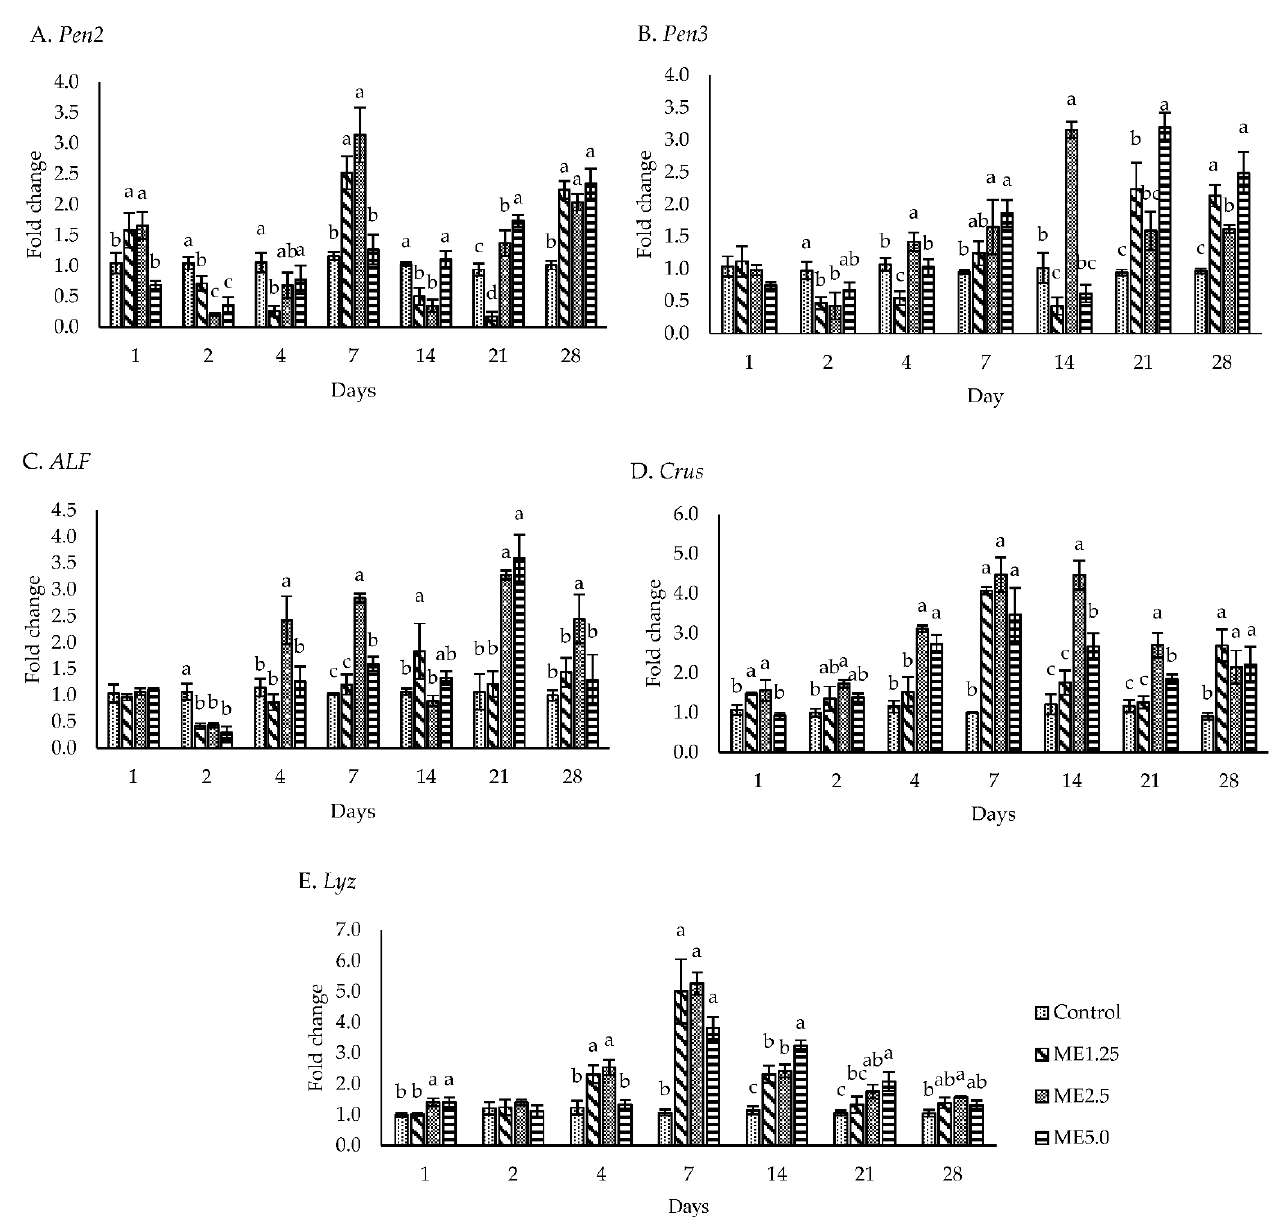
Figure 4. Antimicrobial peptides. The effect of different concentrations of moringa extract in diet (control, ME1.25, ME2.5, and ME5.0) on the expression of Pen2, Pen3 , ALF , Crus , and Lyz in the hemocytes of whiteleg shrimp. The data are expressed as the mean ± standard deviation ( n = 3). Bars with different letters at the same time point are significantly different ( p < 0.05).